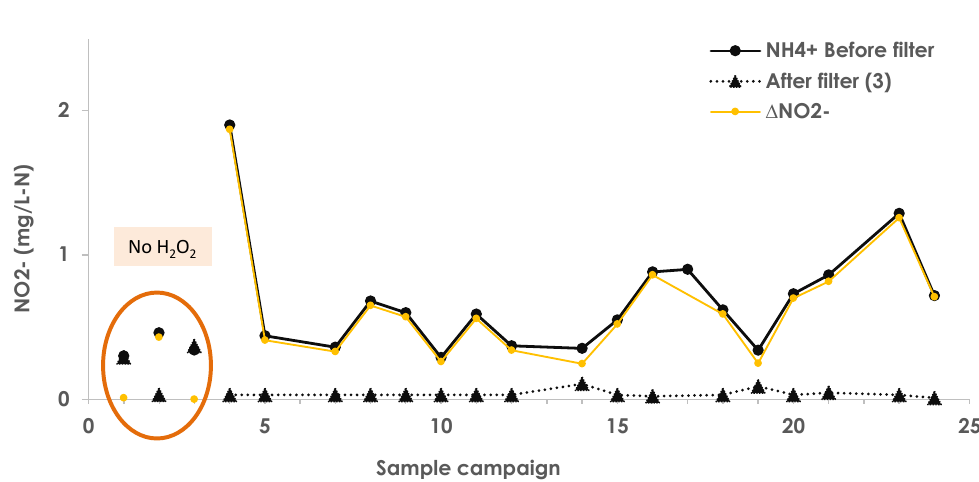
Figure A5. Concentrations and the removal of DOC ( a ) and UVA (UV 254 ) ( b ) over sampling campaigns before the biofilter (BF) and after the biofilter (AF), which was also sorted by feed values of ammonium during experiments with H 2 O 2 addition. Reference campaigns of no H 2 O 2 are circled in orange.